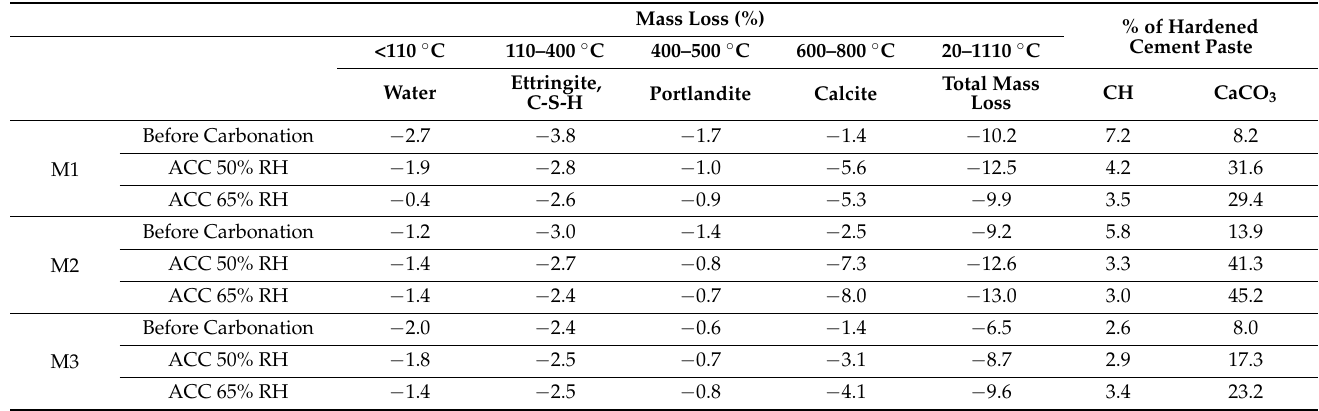
Table 5. Comparison of mass loss and amount of portlandites and calcite at different ambient humidities for accelerated carbonation (3 vol.%) at pre-storage humidity 65%; 7d.